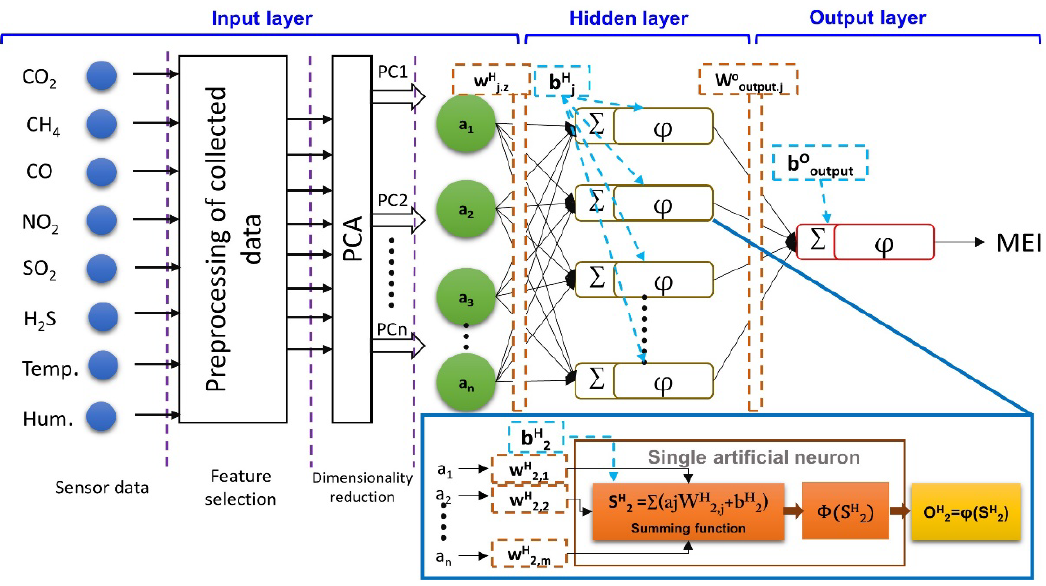
Figure 5. Network architecture of the multilayer perception-artificial neural network (MLP-ANN) for the mine environment index (MEI).